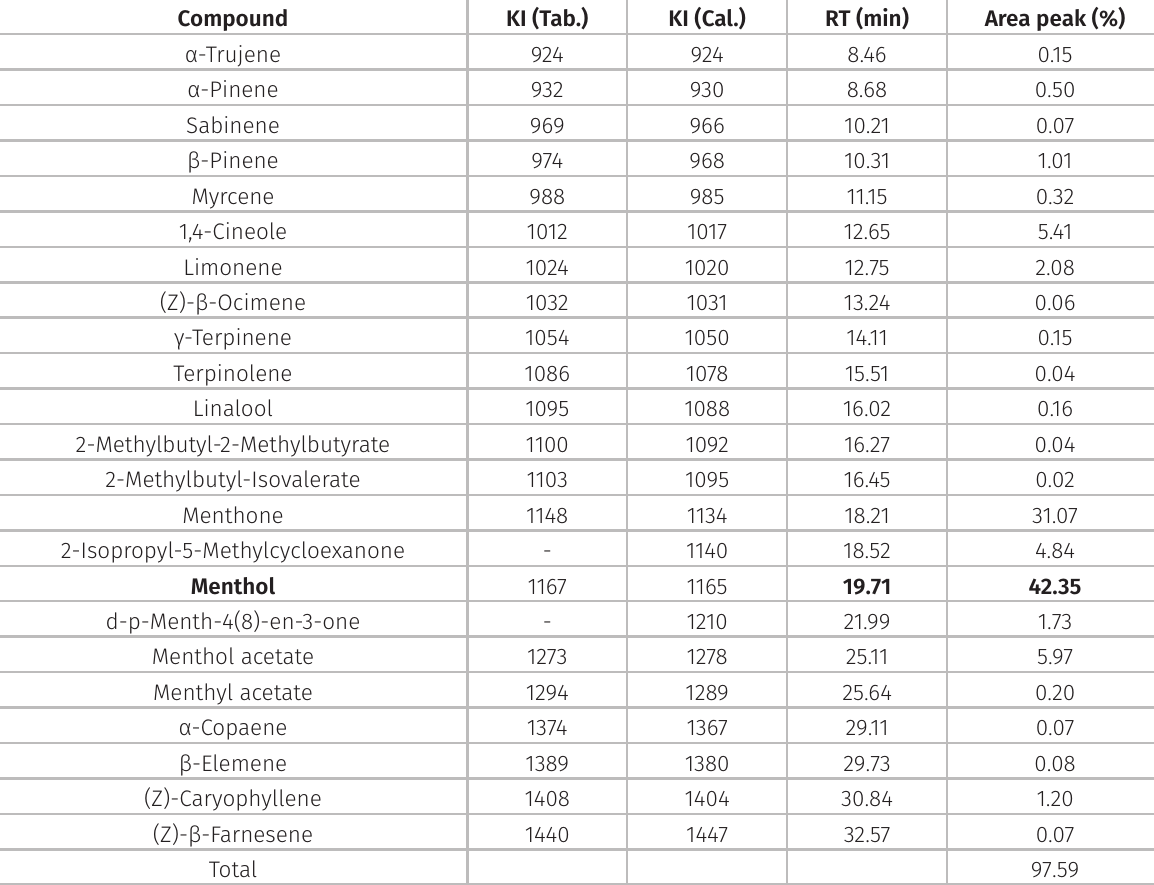
Table I. Chemical profile of Mentha piperita L. essential oil, collected in Alegre - ES. Compound KI